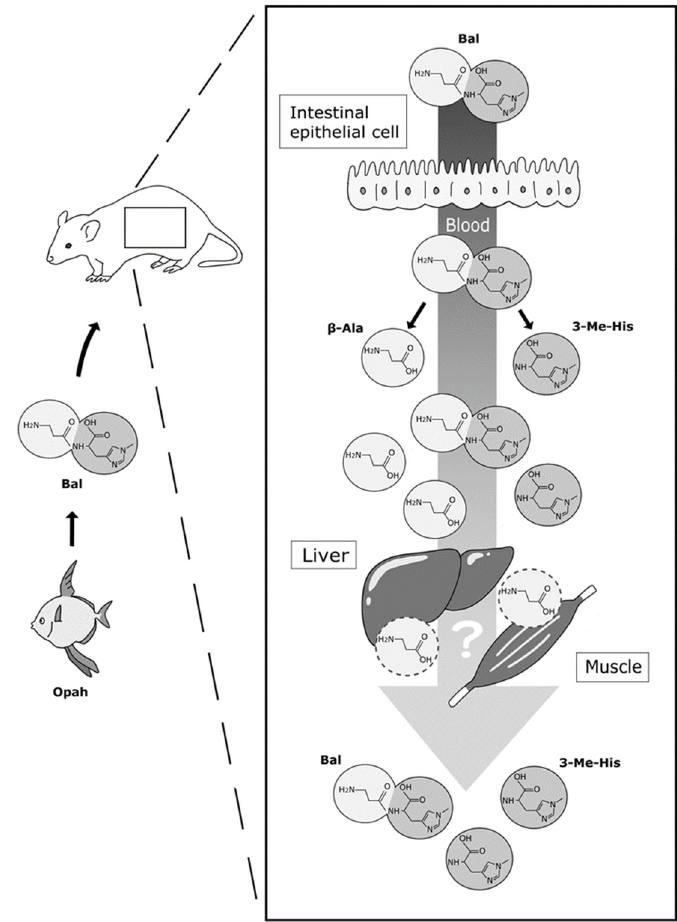
Figure 7. Image of suspected mechanisms for the absorption of Bal and its constituents. Dark and light shades of grey indicate β -Ala and 3-Me-His.